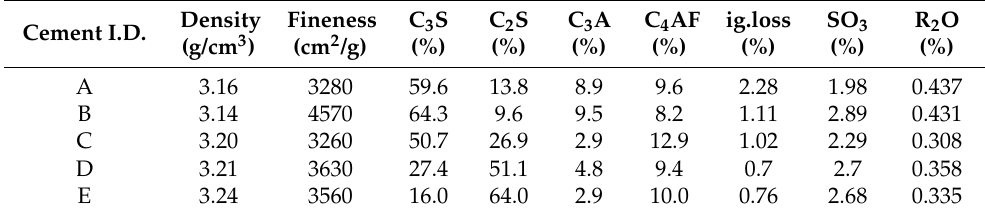
Table 1. Properties of cementitious materials.